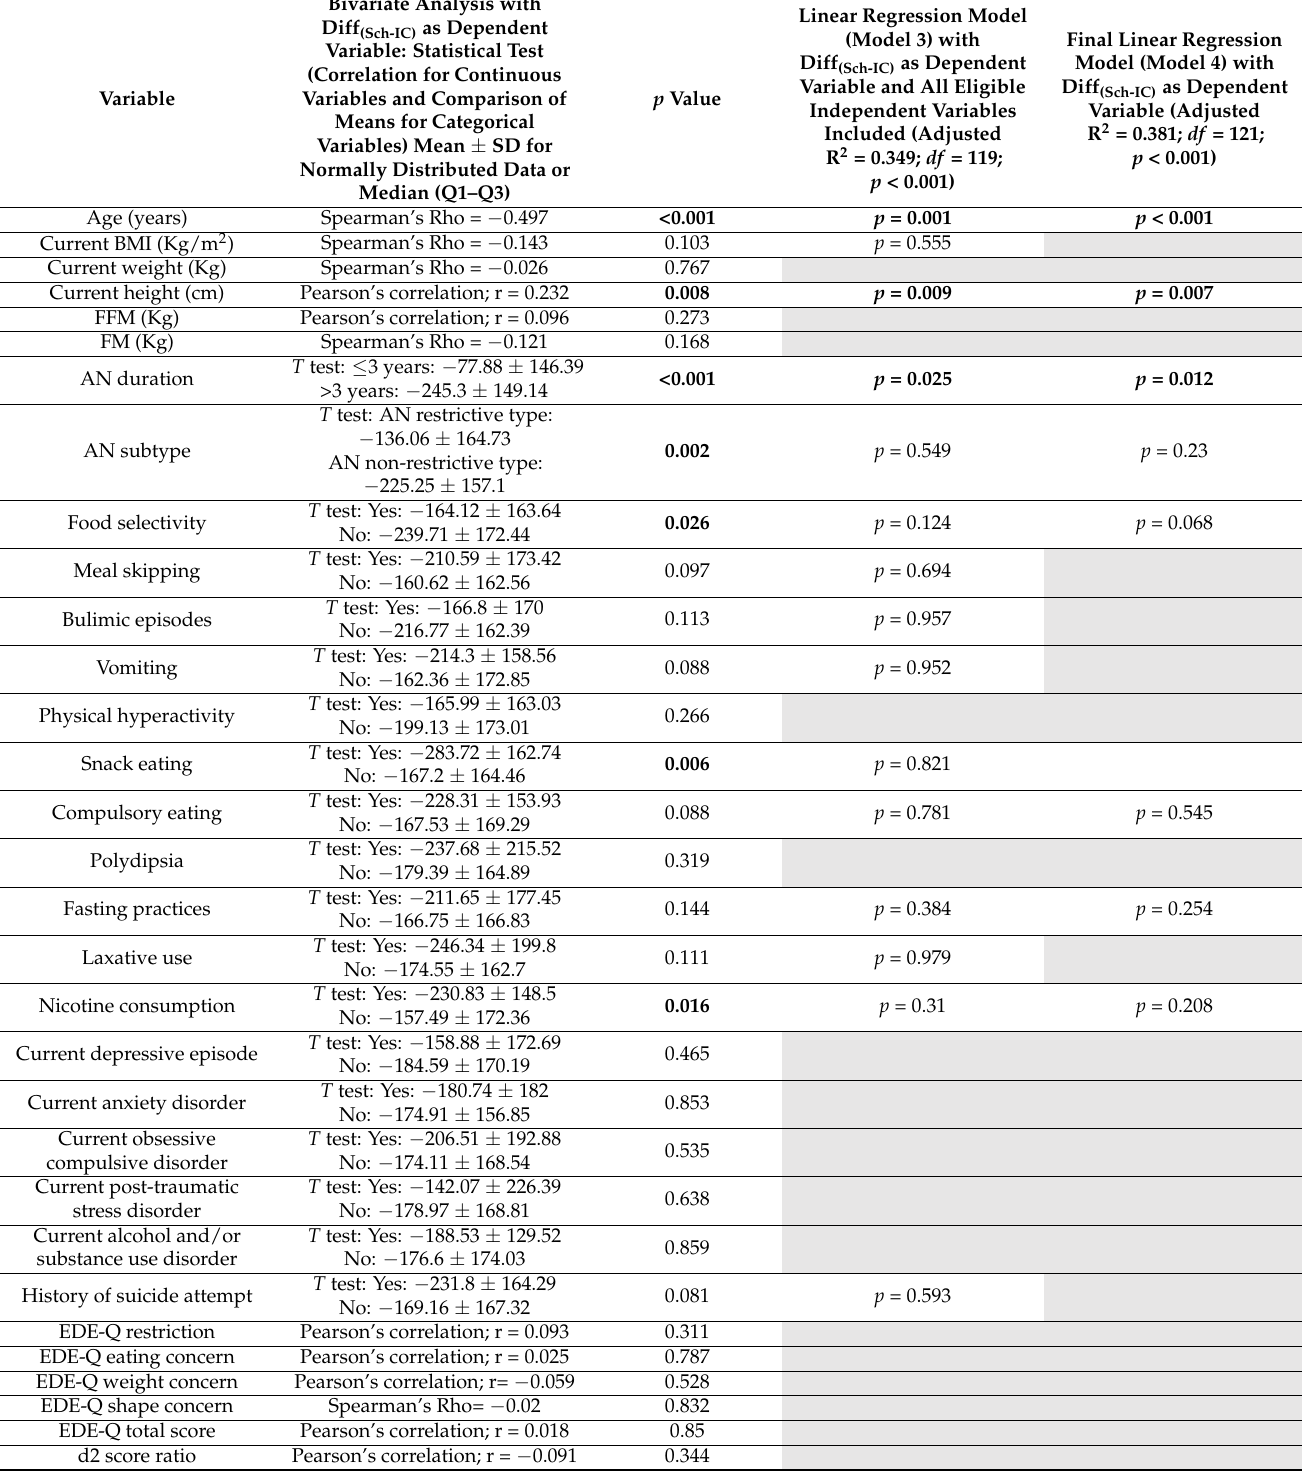
Table 3. Bivariate and multivariate analyses of factors associated with Diff (Sch-IC)